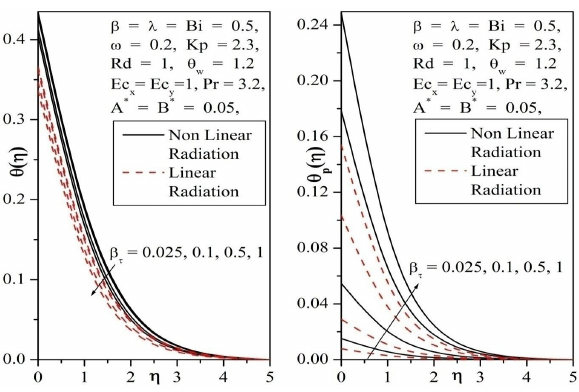
Fig. 15: Dimensionless temperature profiles for different values of Ec y .